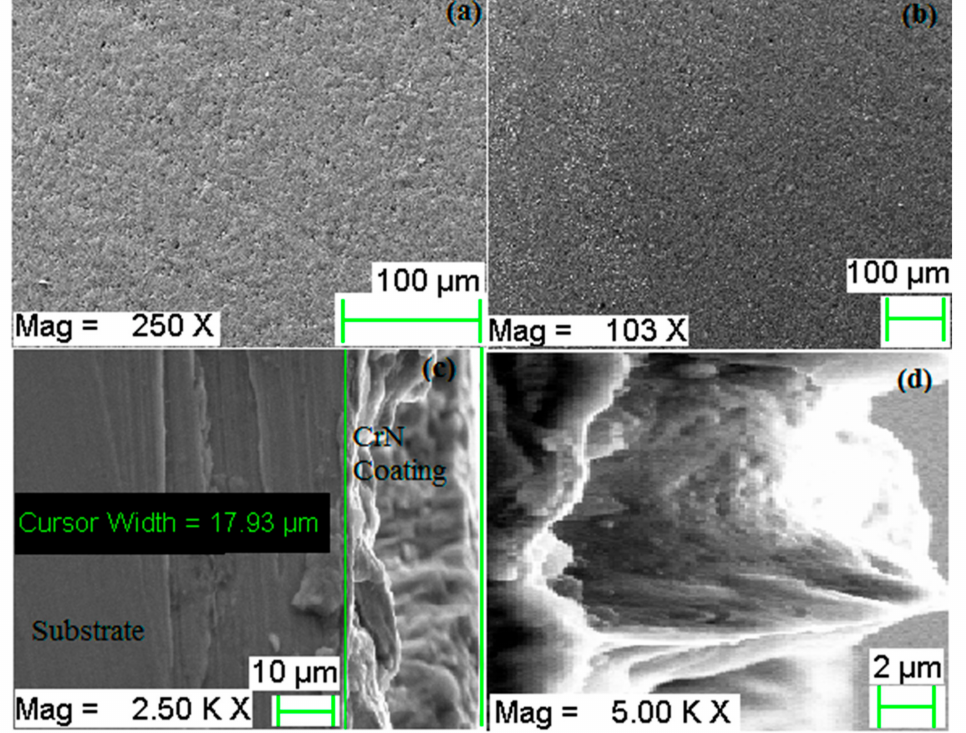
Figure 3. Morphology of CrN coating as deposited, ( a , b ) top view of coating at di ff erent magnifications,